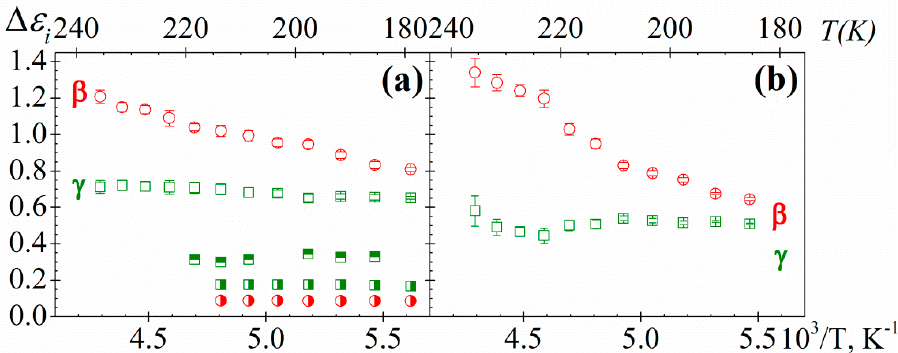
Figure 11. Temperature dependence of the strength for γ (squares) and β (circles) relaxations of ( a ) PAzMa1 and ( b ) PAzMa2 samples. In ( a ) has been shown the strength relaxation values corresponding to the PEOEMA (square with right half black, circle with right half black) and CEOEMA (square with top half black) samples [9].